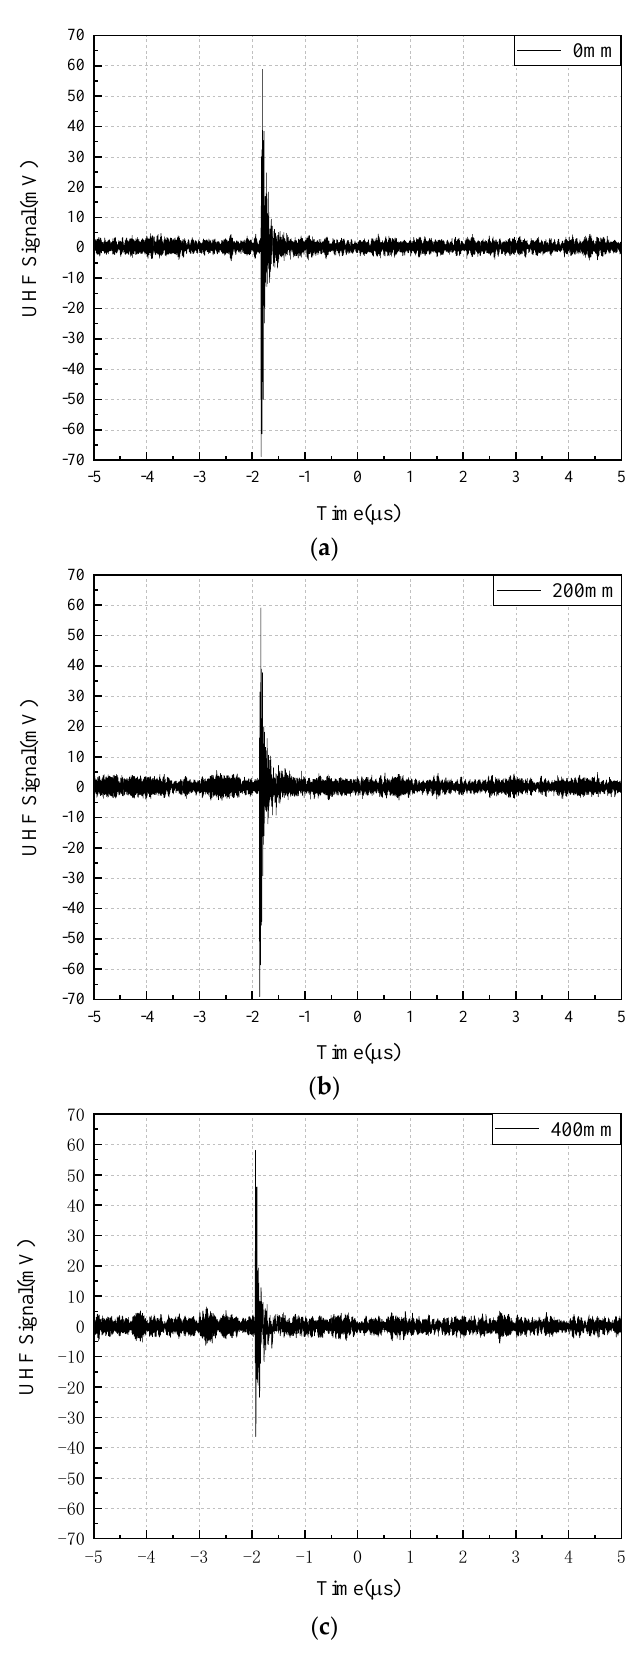
Figure 16. Different bending degree antenna detection PD signal waveform: ( a ) 0 mm; ( b ) 200 mm; ( c ) 400 mm.